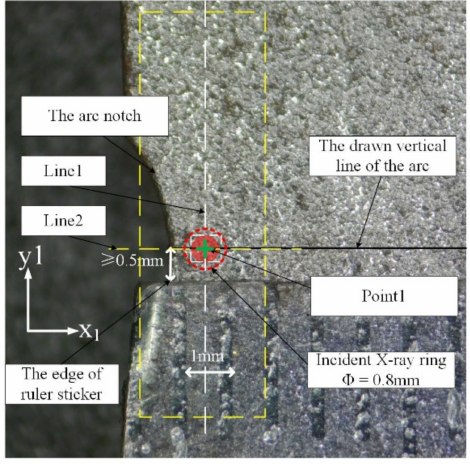
Figure 10. The location of Point1 and residual stress measurement setup.